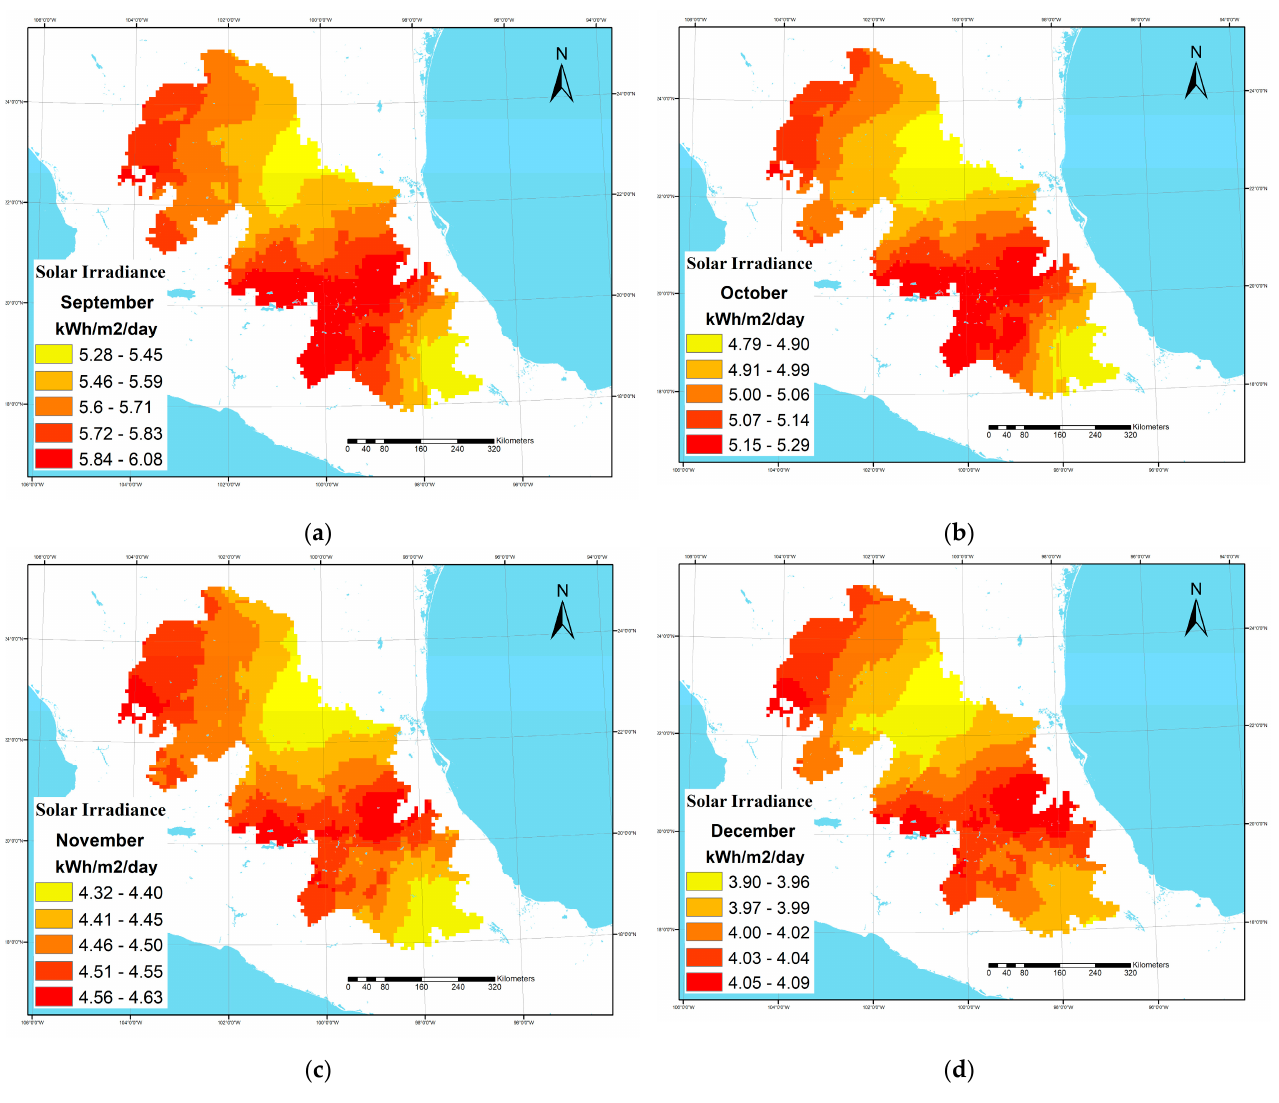
Figure 12. Average solar global irradiation in Central Mexico in ( a ) September, ( b ) October, ( c ) November, and ( d ) December.